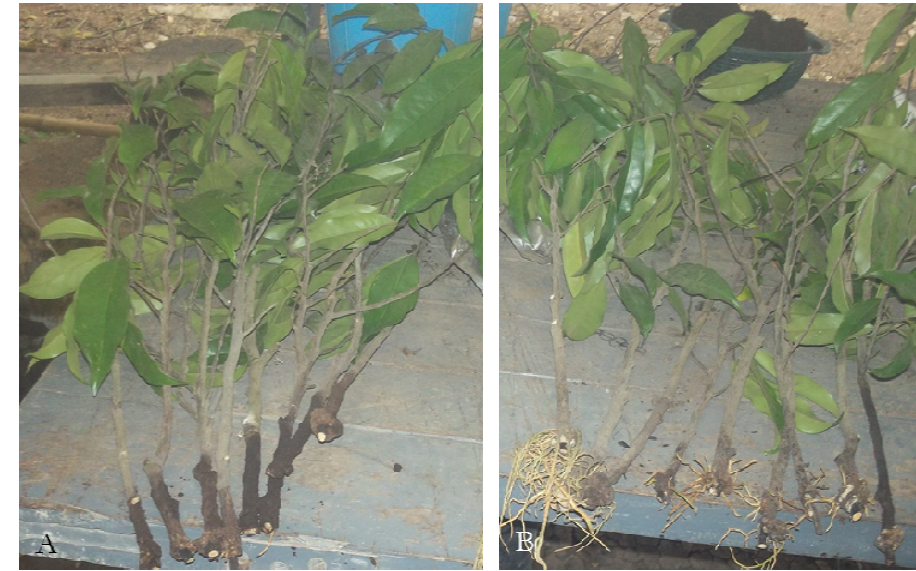
Fig. 3. Rooting system in D. tripetala. A: Air-layering using saw-dust. B: Air-layering using sterilized sharp sand